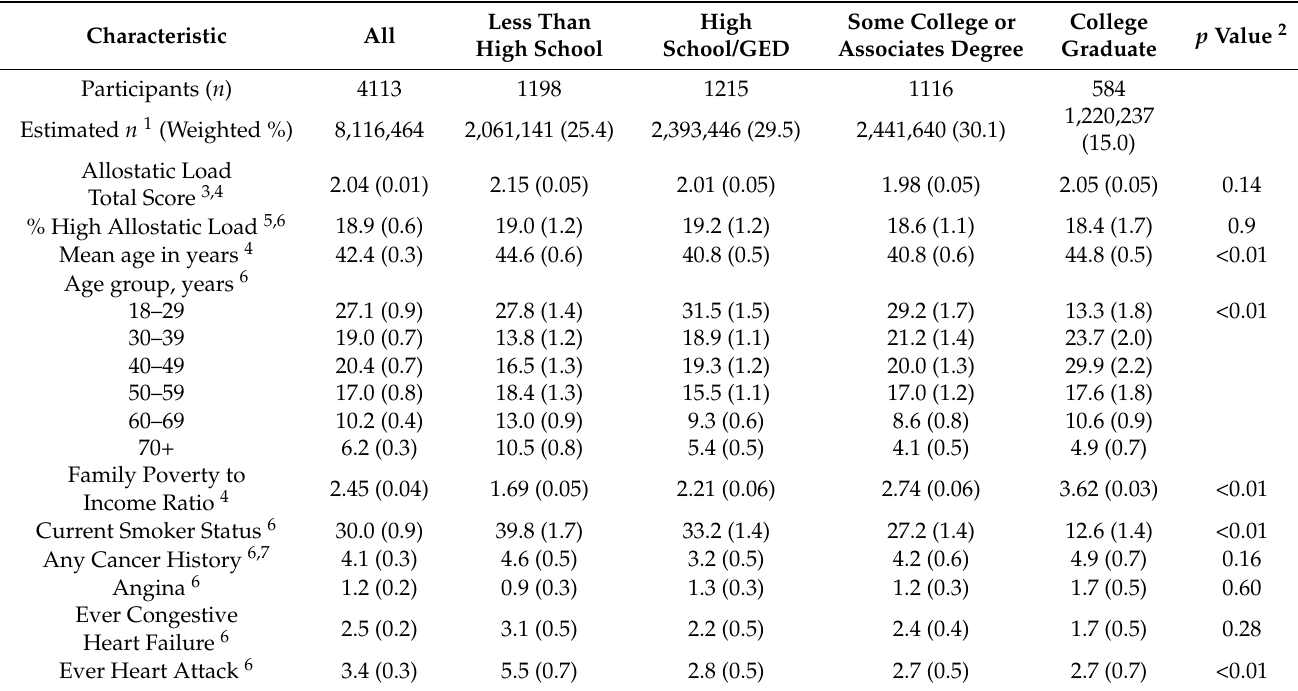
Table 1. Demographic characteristics, personal health, and medical conditions by educational status, among 4113 Black men, an estimated 8,116,464 US residents from the National Health and Examination Survey (NHANES)